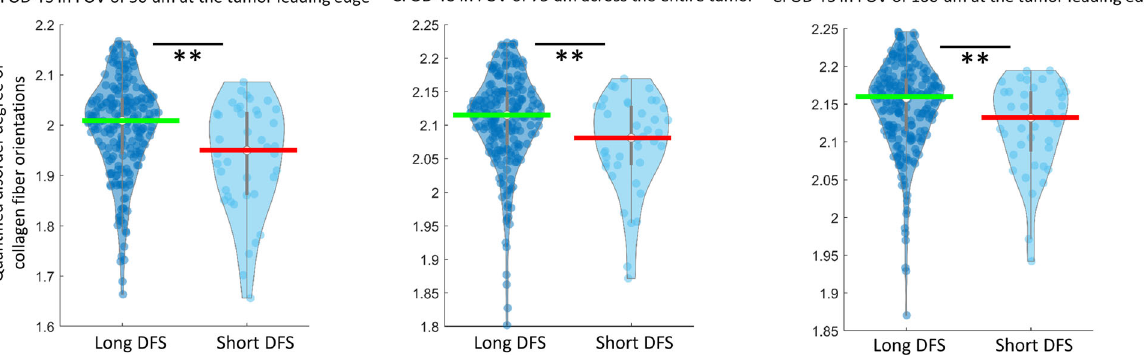
Fig. 1 Top CFOD-TS features distribution. Distribution of top three CFOD-TS features between patients with long DFS (DFS ≥ 5 years) and short DFS (with an event & DFS < 5 years) in S t + v (S t + S v ) with each point representing one single patient, including CFOD-TS features derived from FOV (left to right) in 50 um at tumor leading edge; in 75 μ m across the whole tumor and 100 μ m at the tumor leading